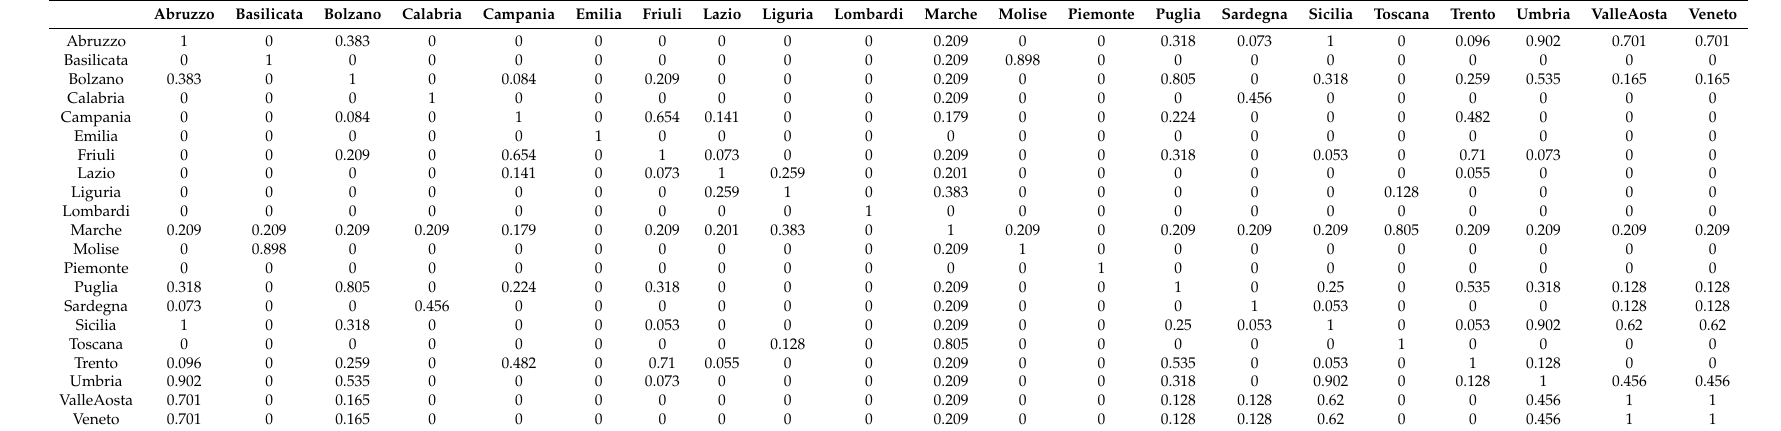
Table A53. Similarity values of Total Cases network in the fourth week.